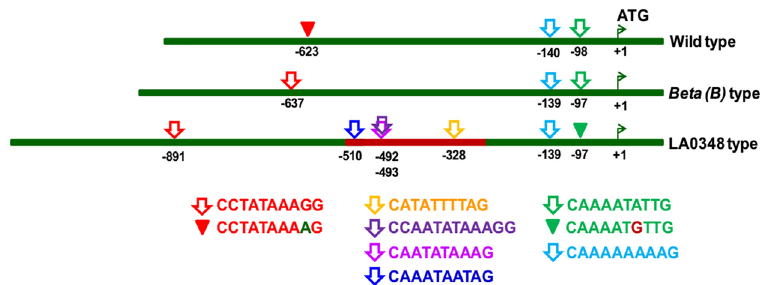
Fig 6. Variability of RIN TF binding sites in CYC-B promoters. The nucleotide sequences upstream of CYC-B gene in WT, Beta (B) type and LA0348 type are diagrammatically represented with green bars. The red coloured portion in LA0348 type represents the probable NUPT fragment. The RIN binding sites are indicated with arrows, and the altered sites are represented by triangles above the bars. The exact position of the first nucleotide in each case is mentioned below the bars. Different RIN binding sequences predicted by PLACE are indicated with different colours. The element CCTATAAAGG is CARGATCONSENSUS. The elements CAAAATATTG, CAAAAAAAAG, CATATTTTAG, CAATATAAAG and CAAATAATAG are CARGCW8GAT type and the element CCAATATAAAGG is CARGNCAT